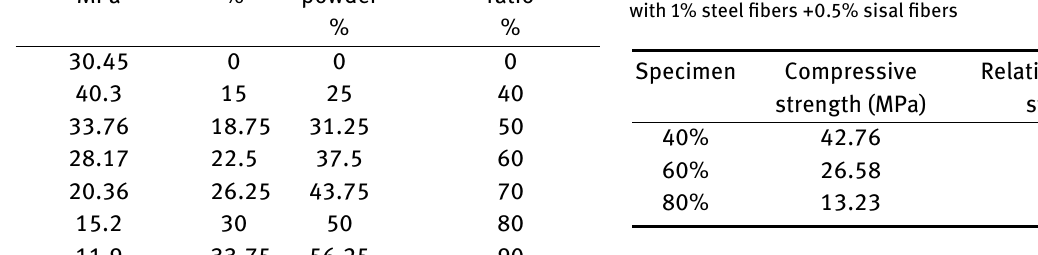
Table 14: Compressive strength for geopolymer mortat